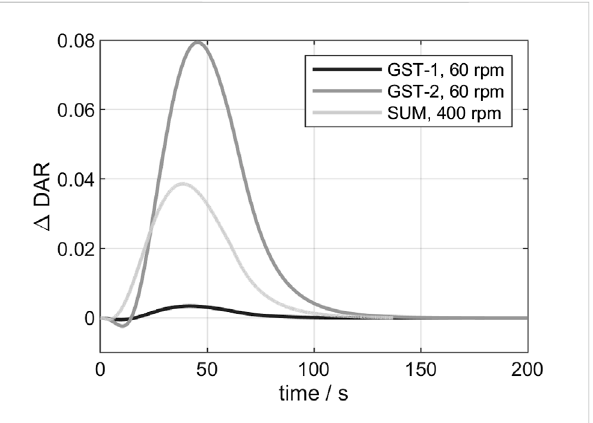
FIGURE 4 Comparison of 0D- and 3D-model predictions of the ADC conjugation kinetic in GST-1 with the experimentally determined kinetic for the fi rst 600 s.